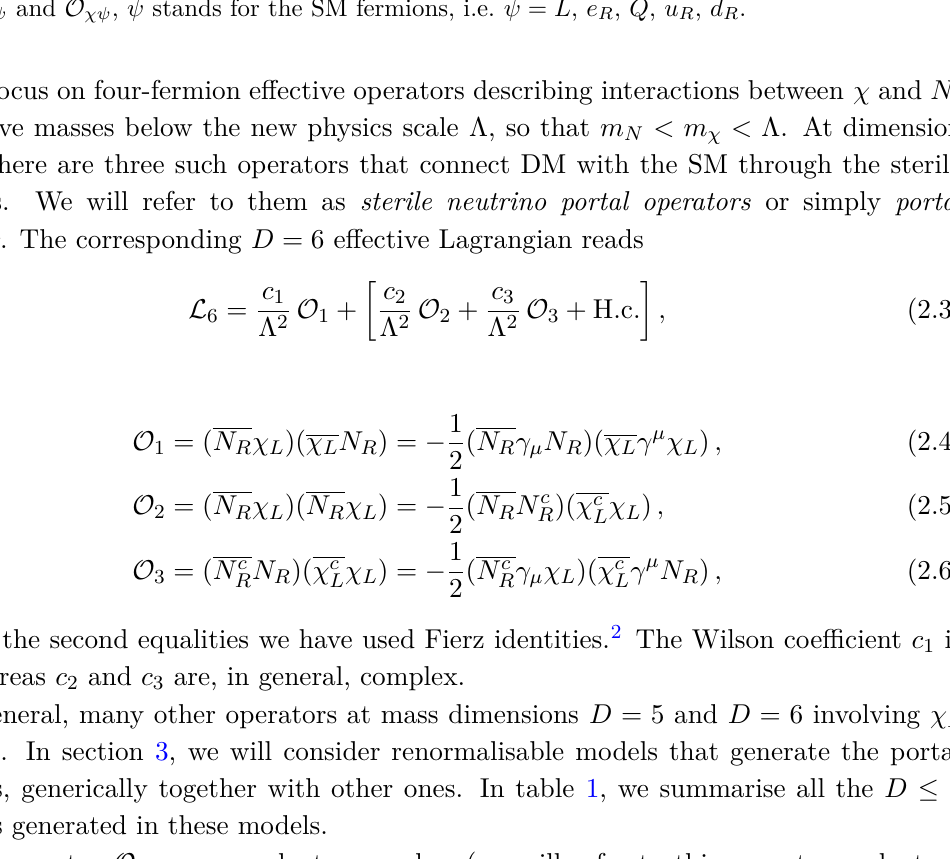
, are generated by integrating out a scalar and/or vector Ψ J is a consequence of the non-linear field redefinition Ψ J , χ , L and e (see details in section 3.2.2.). Finally, in R L R